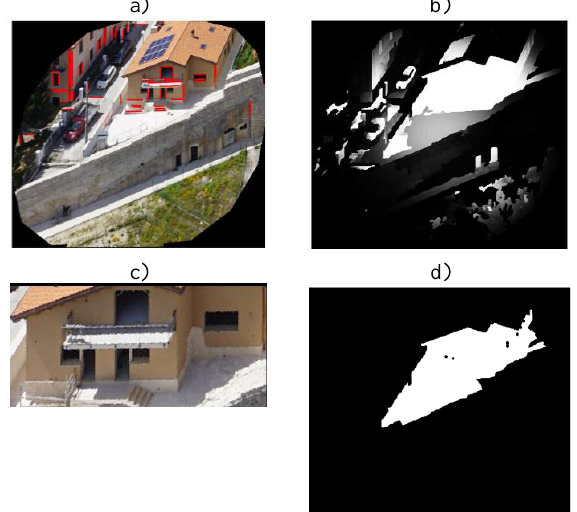
Figure 10 Results of the façade line segments and salient object map: a) façade line segments overlaid in buffered façade patch, b) real-time salient object, c) final refined facade patch, d) binary image of the salient object detection in